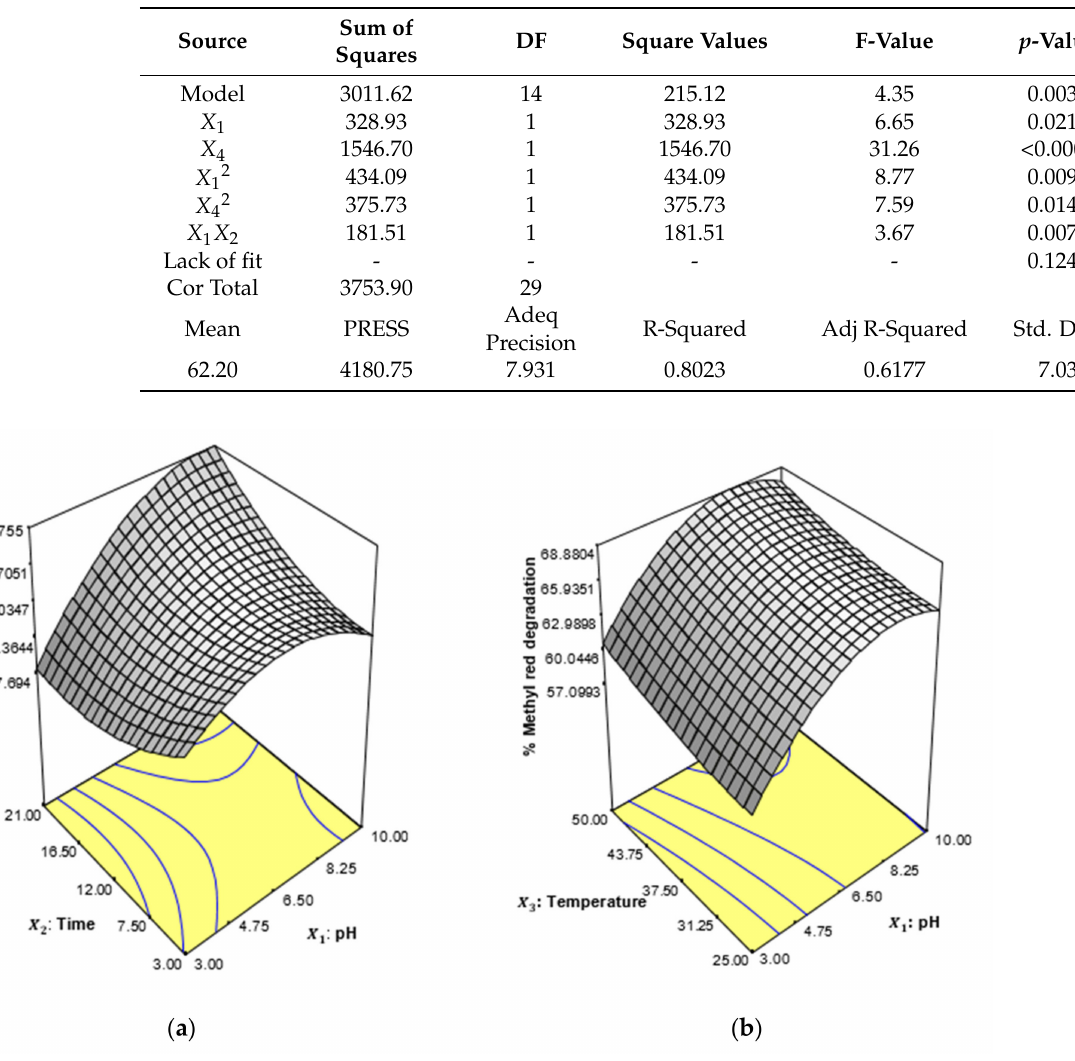
Table 4. ANOVA indicating percent degradation of methyl red dye.